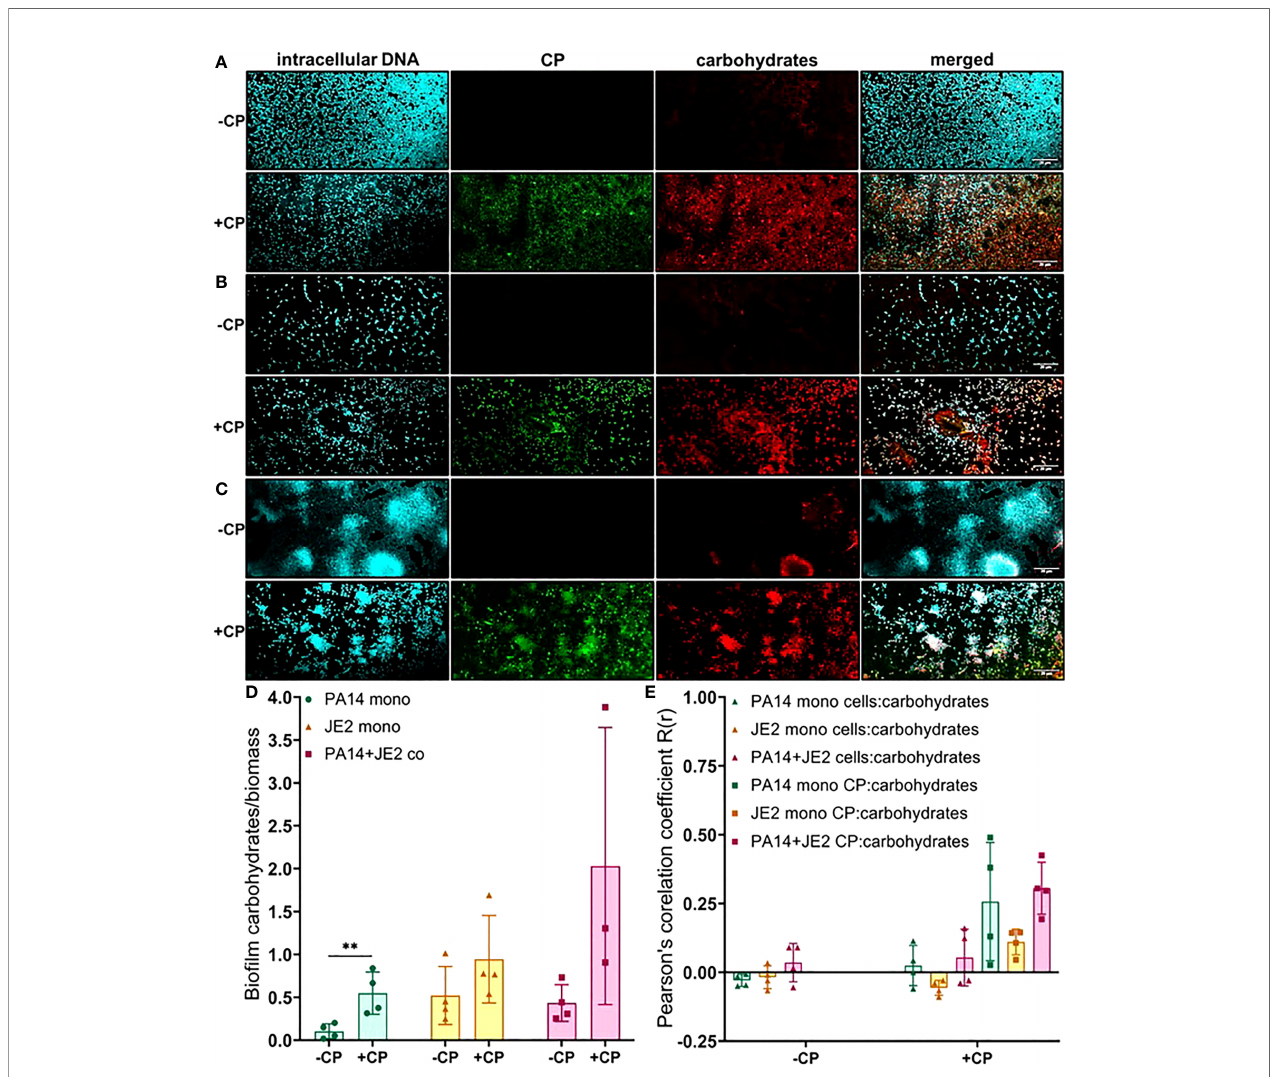
FIGURE 6 | Addition of CP leads to an increase in EPS carbohydrates in P. aeruginosa monoculture bio fi lms. This fi gure depicts confocal images that represent abundance of carbohydrates in P. aeruginosa and/or S. aureus bio fi lm communities in presence or absence of CP conditions. The fl uorescence dyes Hoechst 33342, Alexa 488, and TRITC ConA correspond to intracellular DNA of microbial cells, CP, and carbohydrates in the bio fi lm EPS of- (A) P. aeruginosa monoculture (B) S. aureus monoculture (C) P. aeruginosa - S. aureus co-culture. (D) Quanti fi cation of carbohydrates per biomass in P. aeruginosa and S. aureus bio fi lms in presence or absence of CP. (E) Colocalization analysis of carbohydrate signals with cells and CP signals show higher correlation with CP compared to cells. Images show 100X magni fi cation and were processed using ImageJ. Bars represent the mean of four biological replicates performed on two independent days. Error bars represent the standard error of mean of the biological replicates. Unpaired t-test (two-tailed) was used to measure statistical signi fi cance. **p ≤